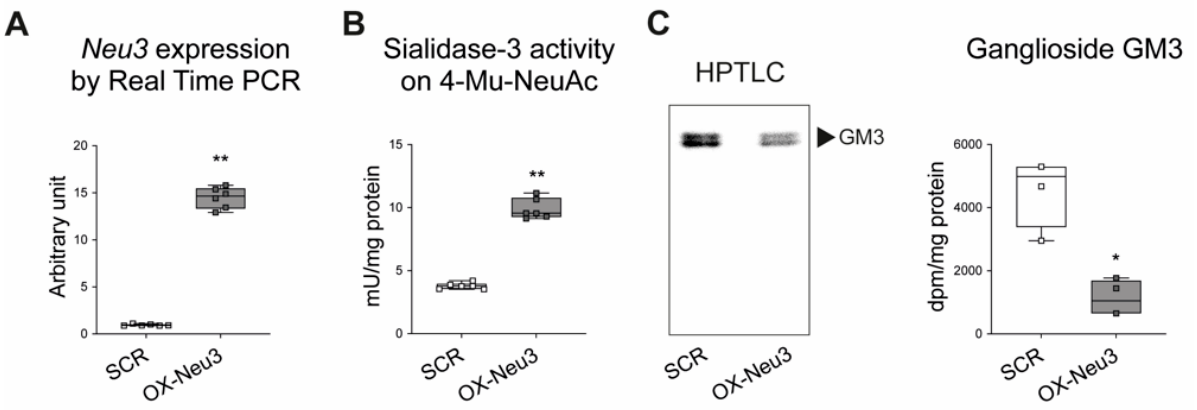
Figure 4. Sialidase-3 overexpression in H9c2 cardiomyoblasts . ( A ) Expression of sialidase Neu3 measured by Real Time PCR; ( B ) enzymatic activity of sialidase-3 measured on the synthetic substrate 4-Mu-NeuAc; ( C ) analysis of ganglioside GM3 by labeling with [3- 3 H]-sphingosine. Left panel ( C ): radiochromatographic image of HPTLC separation of gangliosides contained in the aqueous phase. Right panel ( C ): GM3 quantification expressed as dpm/mg protein. Each square in the graphs represent an experimental replicate. Statistical significance was determined by the nonparametric Mann-Whitney test. * p < 0.05; ** p < 0.01.